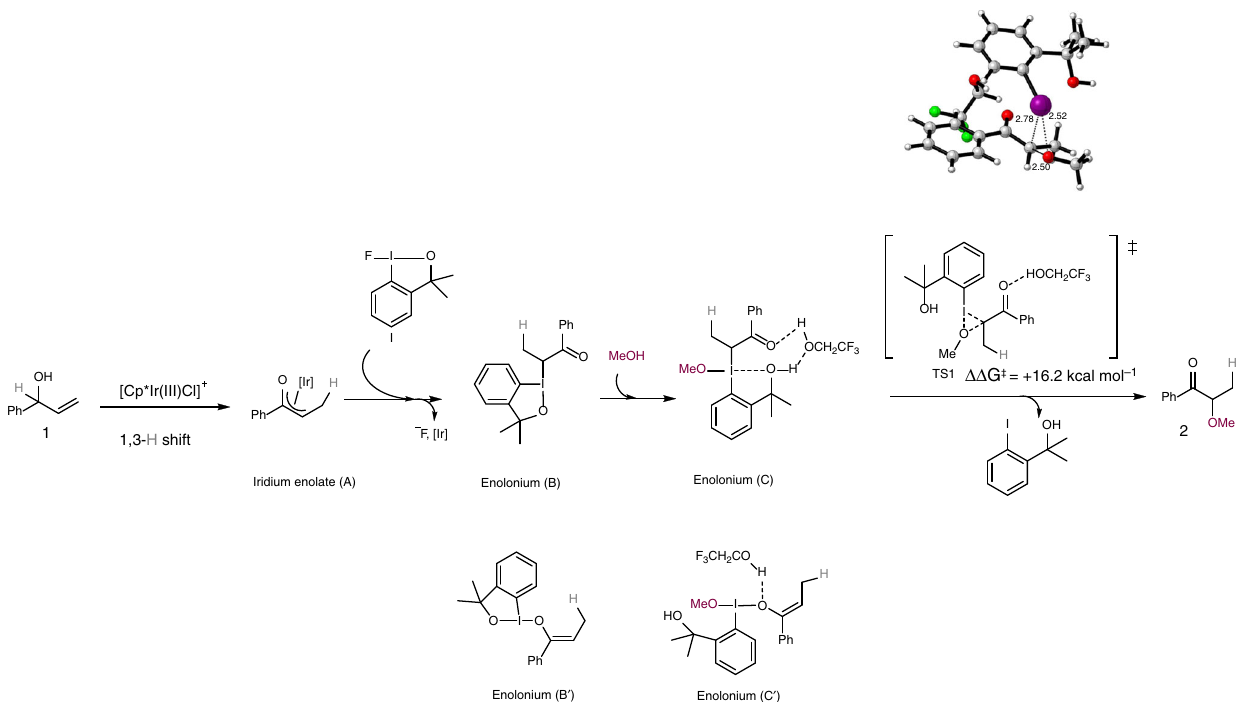
Fig. 5 Proposed intermolecular reaction mechanism. DFT calculations for the umpolung reaction of allylic alcohols with methanol. Values correspond to Gibbs free energies in kcal mol − 1